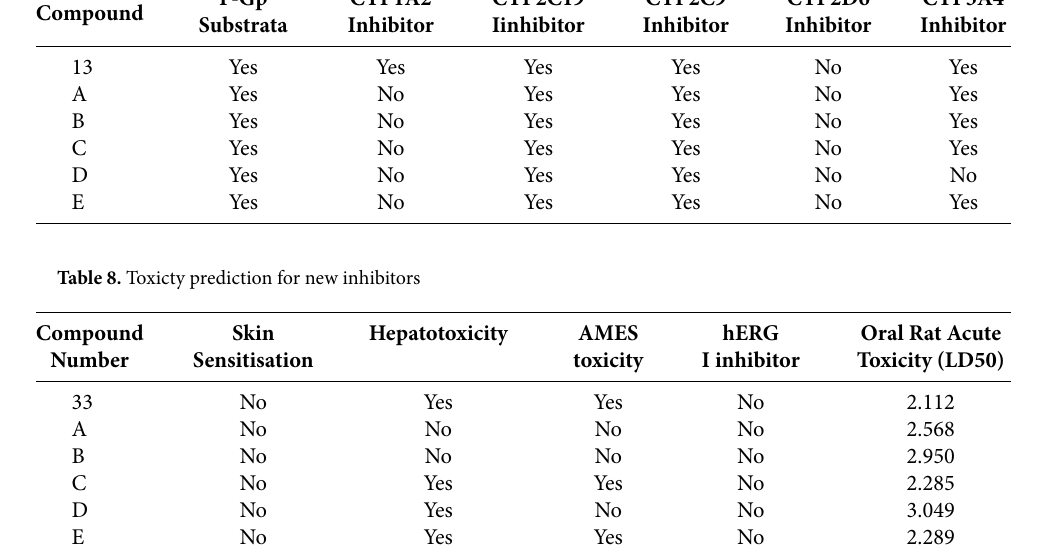
Table 7. Metabolism prediction for new inhibitors Compound